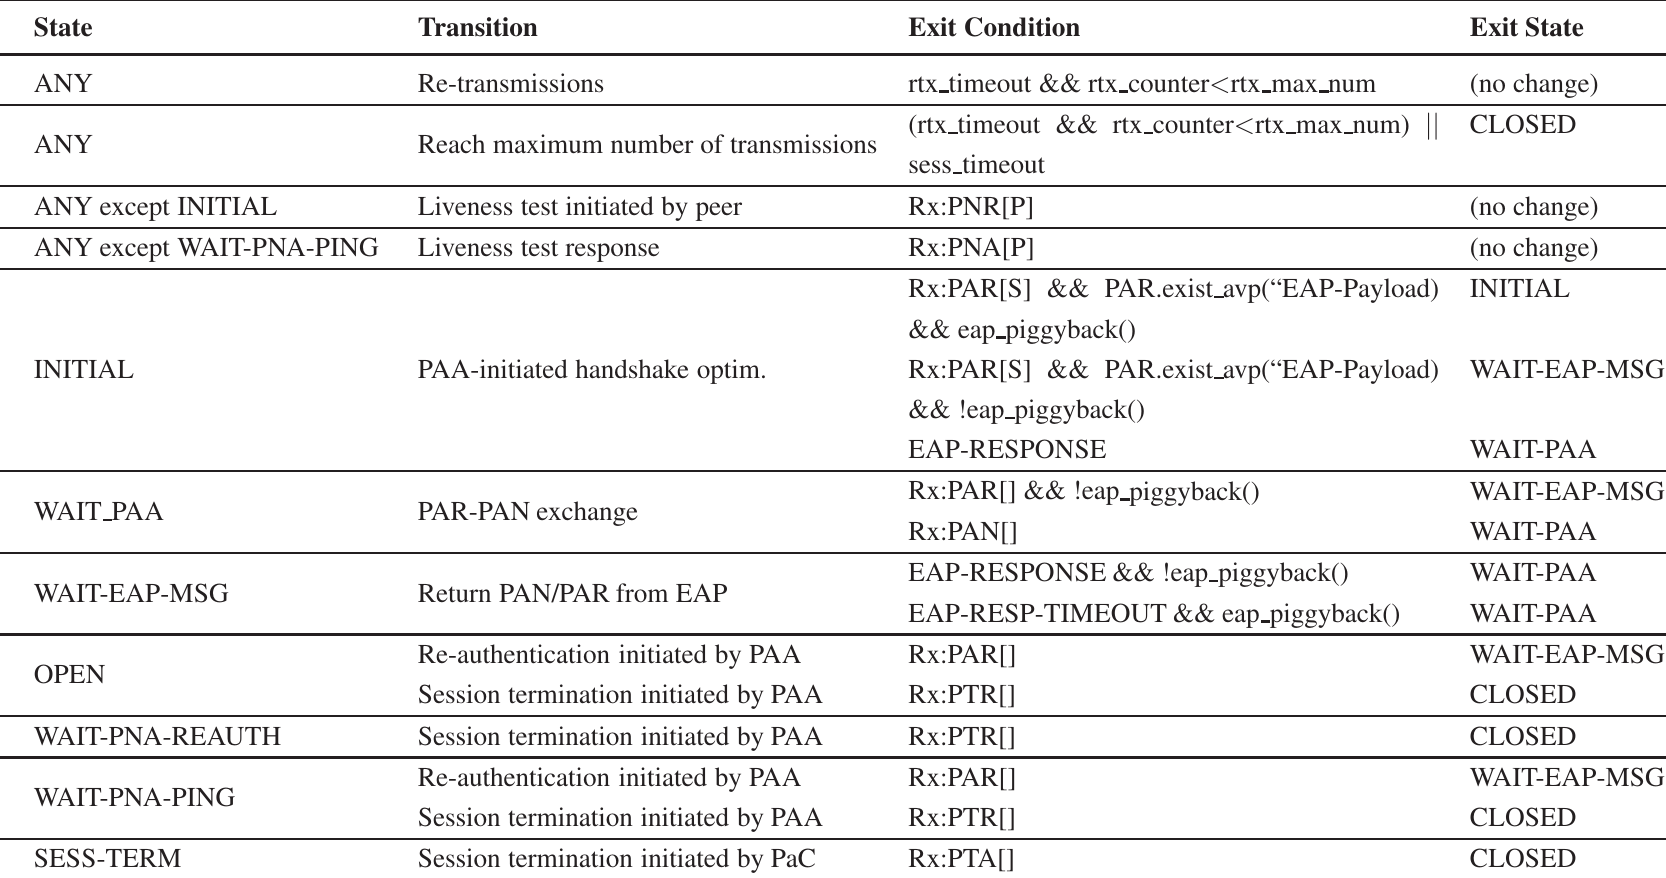
Table A1. Eliminated states in a PaC state